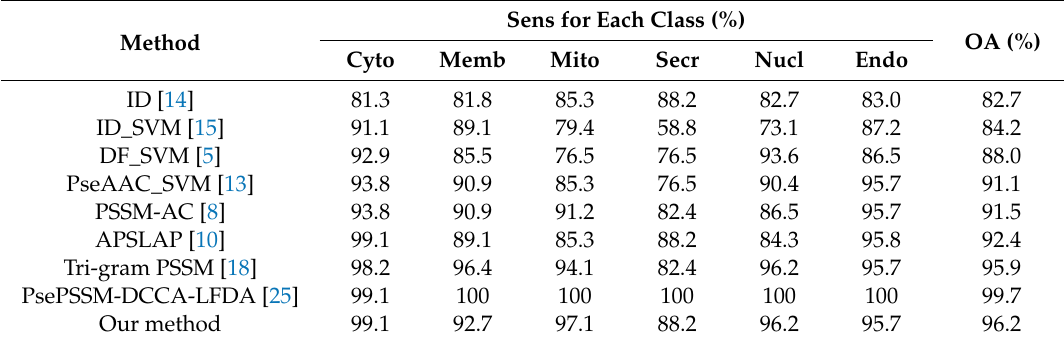
Table 3. Performance comparison of di ff erent methods on the CL317